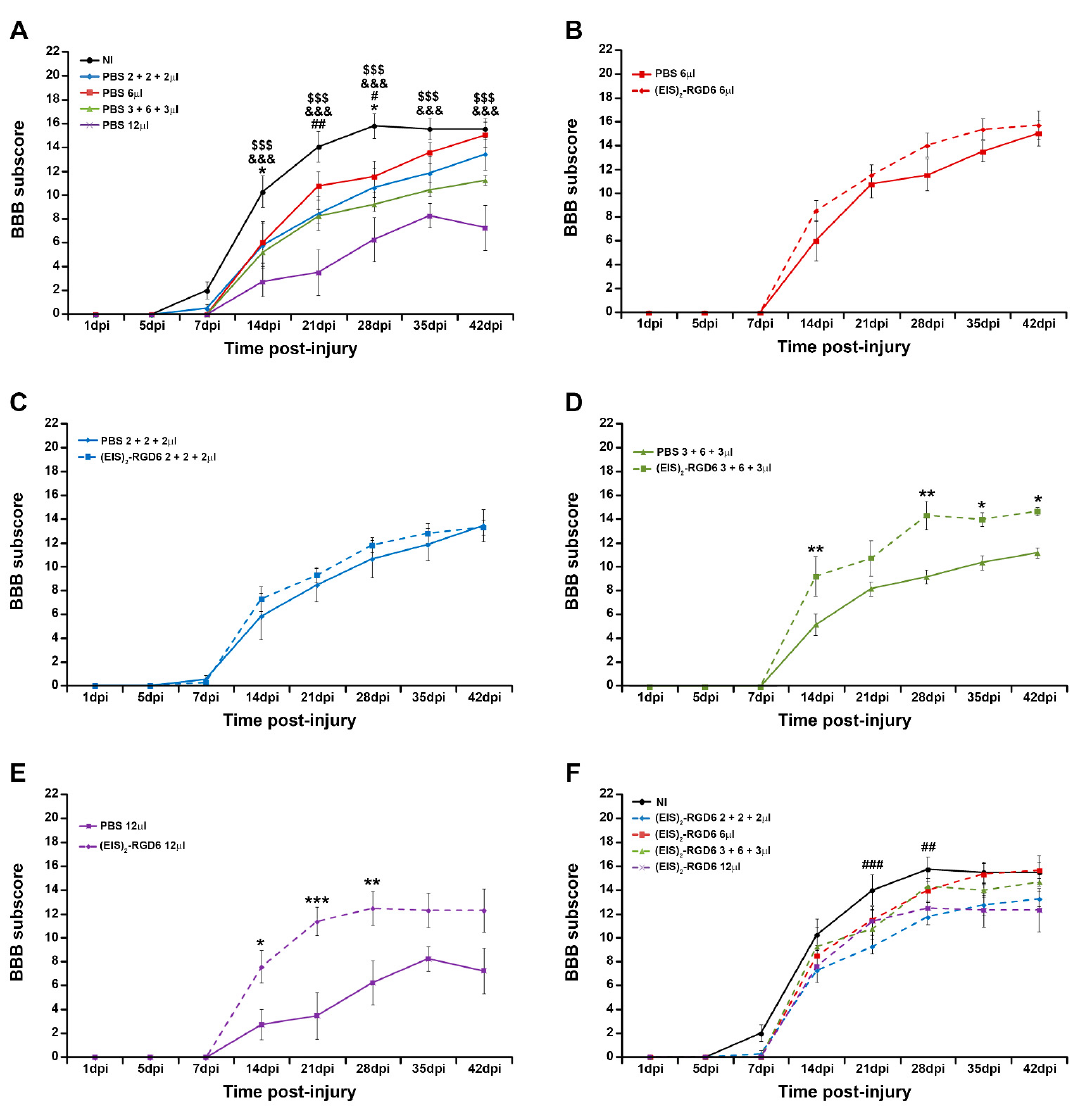
Figure 2. Determination of the injection system: 21-point Basso, Beattie, and Bresnahan open-field test (BBB) sub-score. Graphs show data obtained from the analysis of motor functional recovery using the BBB sub-score in the experimental set performed to determine the best (EIS) 2 -RGD6 injection system [experiment (EIS) 2 -RGD6 I]. The BBB sub-score was assessed at 1, 5, 7, 14, 21, 28, 35, and 42 days post-injury (dpi). The following comparisons are shown: ( A ) Non-injected (NI) group vs. PBS-injected groups (PBS 6 µL, PBS 2 + 2 + 2 µL, PBS 3 + 6 + 3 µL, or PBS 12 µL) (*, p < 0.05 NI vs. PBS 6 µL; #, p 0.05 and ##, p < 0.01 NI vs. PBS 2 + 2 + 2 µL; &&&, p < 0.001 NI vs. PBS 3 + 6 + 3 µL; $$$, p < 0.001 vs. PBS 12 µL); ( B ) PBS 6 µL group vs. (EIS) 2 -RGD6 6 µL group; ( C ) PBS 2 + 2 + 2 µL